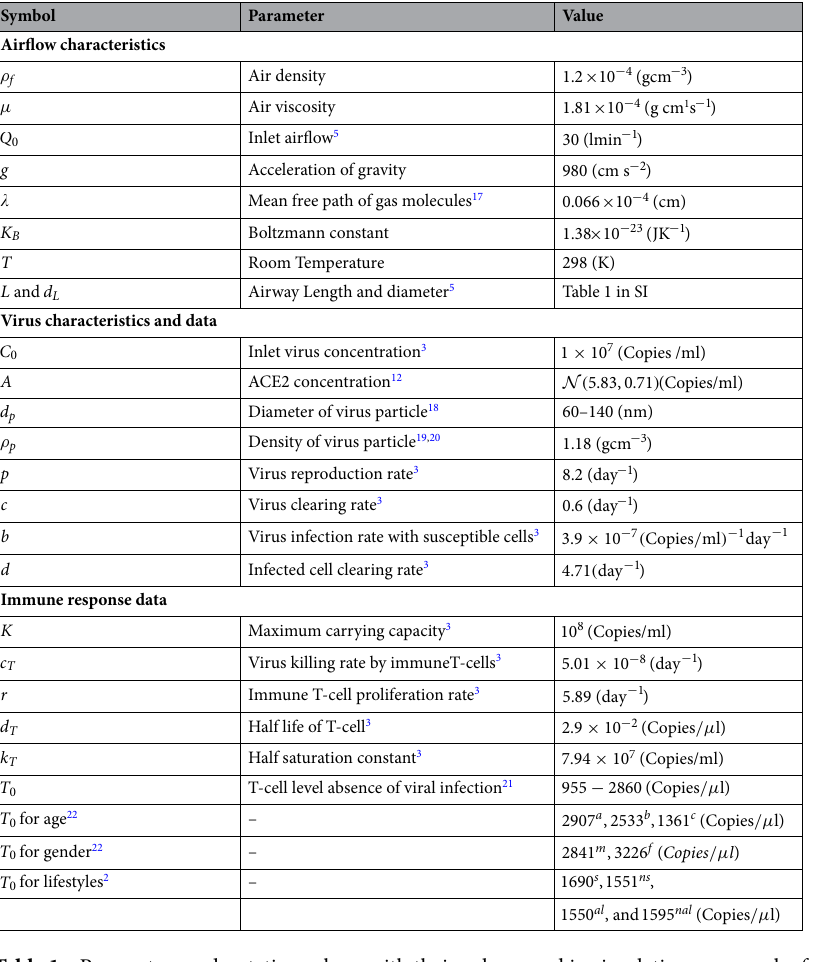
Table 1. Parameters and notations along with their values used in simulations. m —male, f —female, a —20–40, b —40–60, c —60–80 ( years), s —smoking, al —alcohol, ns —not smoking, and nal